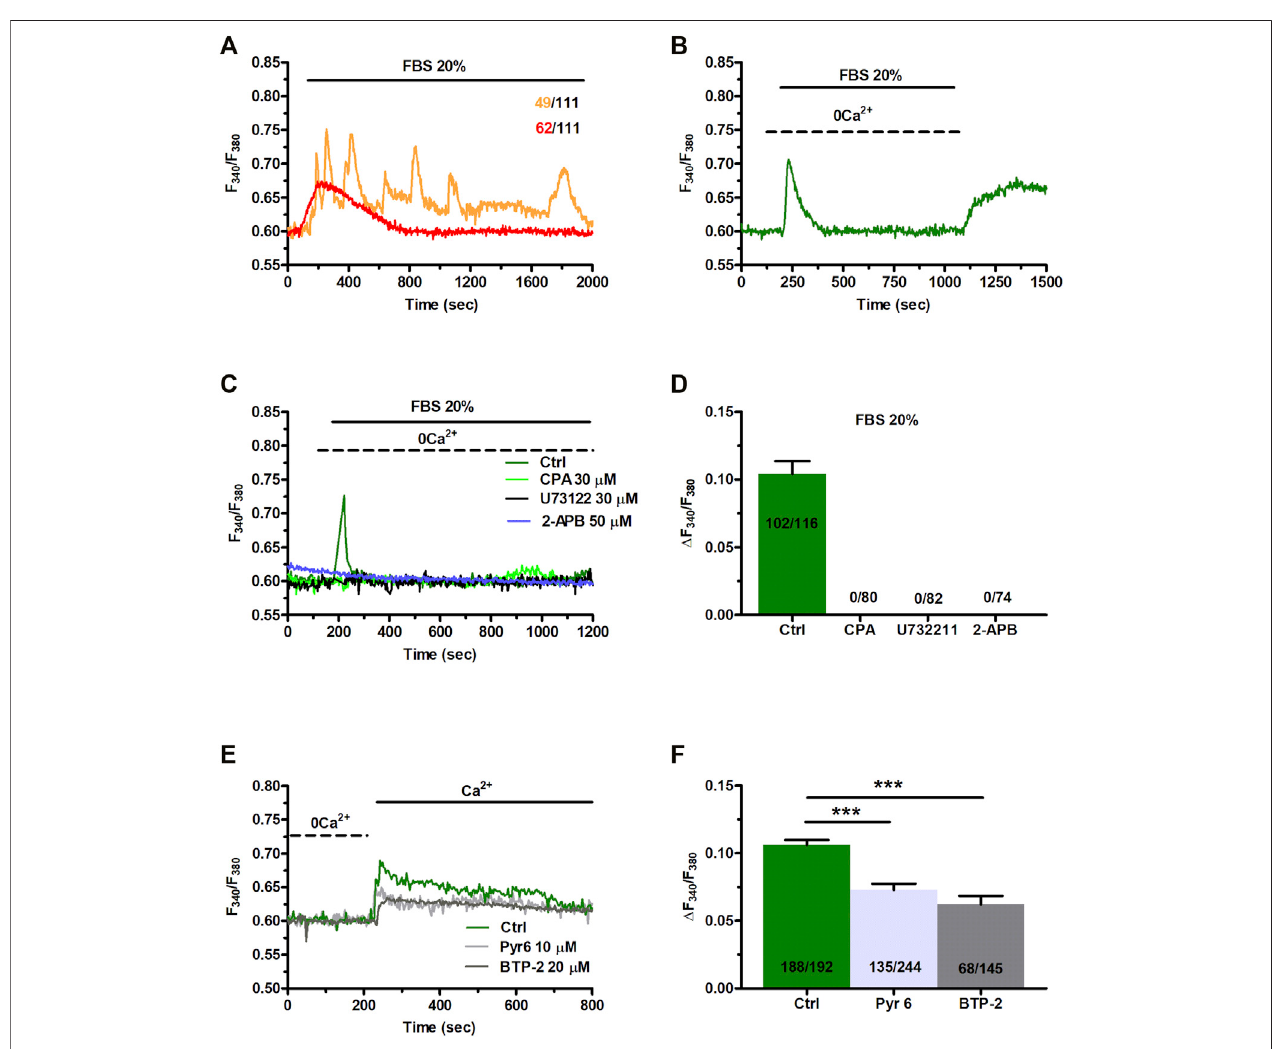
FIGURE6| Fetalbovineserum(FBS)-inducesintracellularCa 2+ releasefromendogenousstoresandenhanceSOCE. (A) 20%FBSinducedoscillatoryortransient increases in [Ca 2+ ] i . (B) Under 0Ca 2+ conditions, 20% FBS induced a transient elevation in [Ca 2+ ] i . Subsequent re-addition of extracellular Ca 2+ , 100 s after agonist removal from the bath, resulted in a second bump in [Ca 2+ ] i that was indicative of SOCE. (C) The intracellular Ca 2+ release evoked by 20% FBS (Ctrl) was inhibited by depletingtheERCa 2+ poolwithCPA(30 μ M,30 min),byblockingInsP 3 Rswith2-APB(50 μ M,30 min),orinhibitingPLCwithU73122(10 μ M,10 min). (D) Mean± SE of the amplitude of the peak intracellular Ca 2+ response to 20% FBS under the designated treatments. (E) Subsequent to store depletion by 20% of FBS application (data are not shown her (E) , FBS were washed out from bath, then extracellular Ca 2+ added to the bath to bath in the presence and absence of SOCE inhibitors, Pyr6 (10 μ m,10 min)orBTP-2(20 μ m,20 min). (F) Mean±SEoftheamplitude ofCa 2+ entryevokedby20%FBSintheabsence(Ctrl)and presence ofPyr6and BTP-2.The asterisk indicates *** p <